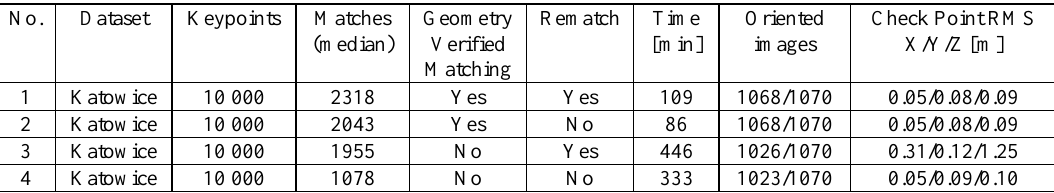
Table 2. Time and effectiveness of orientation in Pix4D regarding to usage of Geometry Verified Matching and Rematch settings.